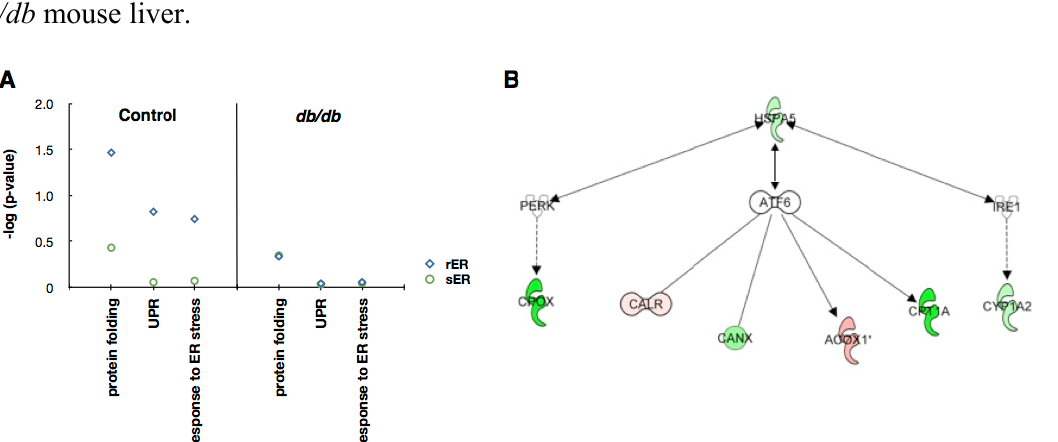
Figure 5. Proteins associated with ER stress. ( A ) Functional distribution of proteins involved in ER stress using Gene Ontology (GO) annotation with the hypergeometric test. Unique proteins showing that the expression levels are higher at least 1.5-fold in each fraction were used for analysis. The degree of enrichment or depletion of identified proteins in a given function category is represented as − log( p ); ( B ) Protein network analysis. IPA-determined network of identified proteins in the rER that may be involved in ER stress signaling. Red, up-regulated in db/db mouse liver; green, down-regulated in db/db mouse